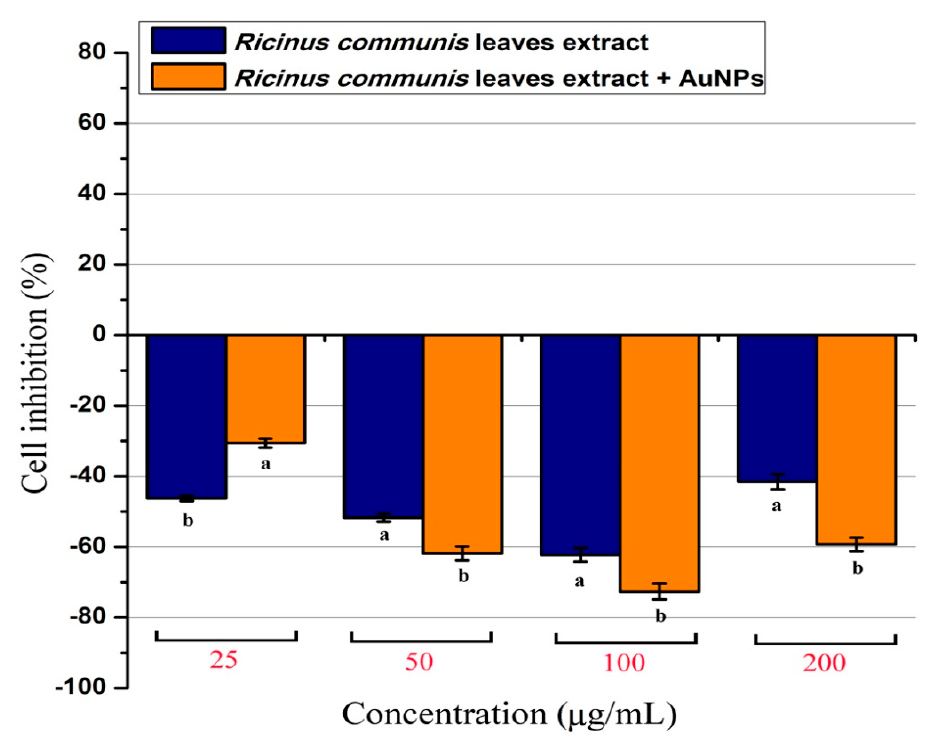
Figure 11. Percentage of normal splenic cells growth stimulation/inhibition after treatment with Ricinus communis leaf extract (RcExt) and gold nanoparticles fabricated with extract (RcExt-AuNPs). All of the data are represented as mean ± standard deviation (indicated as error bars) from three determinations. Bars with letters in each concentration group indicate a significant ( p ≤ 0.05) difference between treatments.